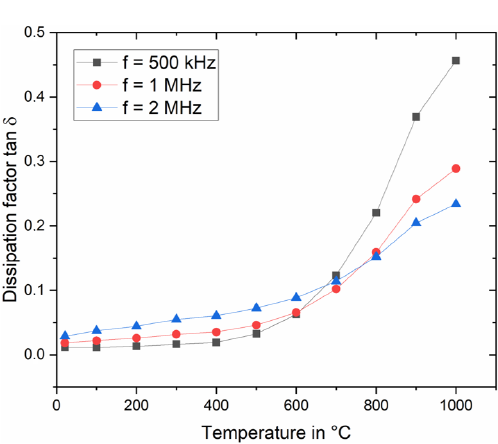
Figure 19. Dissipation factor, tan δ , measured as a function of tem- perature and frequency up to 1000 ◦ C.